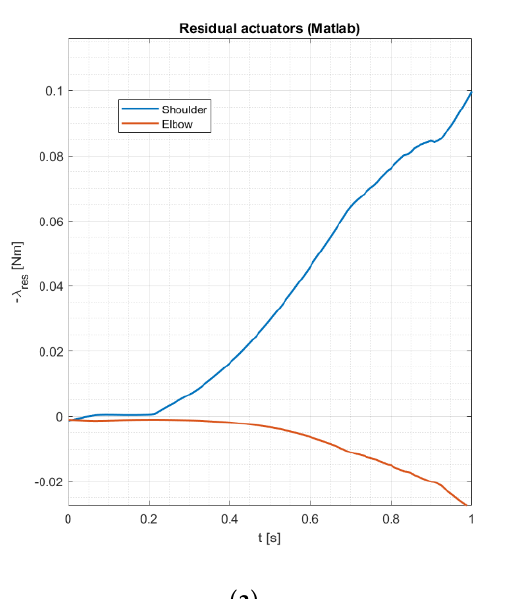
( d ) Figure 20. Upper limb joint reactions: ( a ) shoulder forces, and ( b ) torques, ( c ) elbow forces and ( d ) torques).